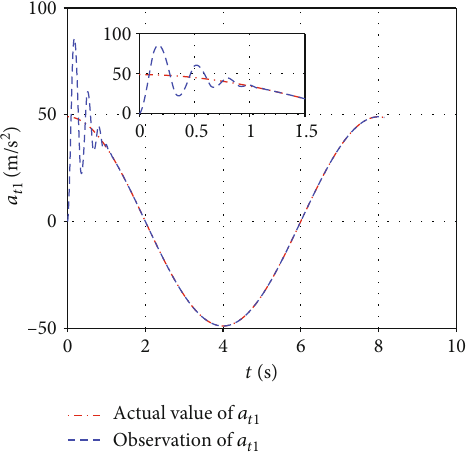
Figure 49: Target acceleration estimation in the pitch plane.